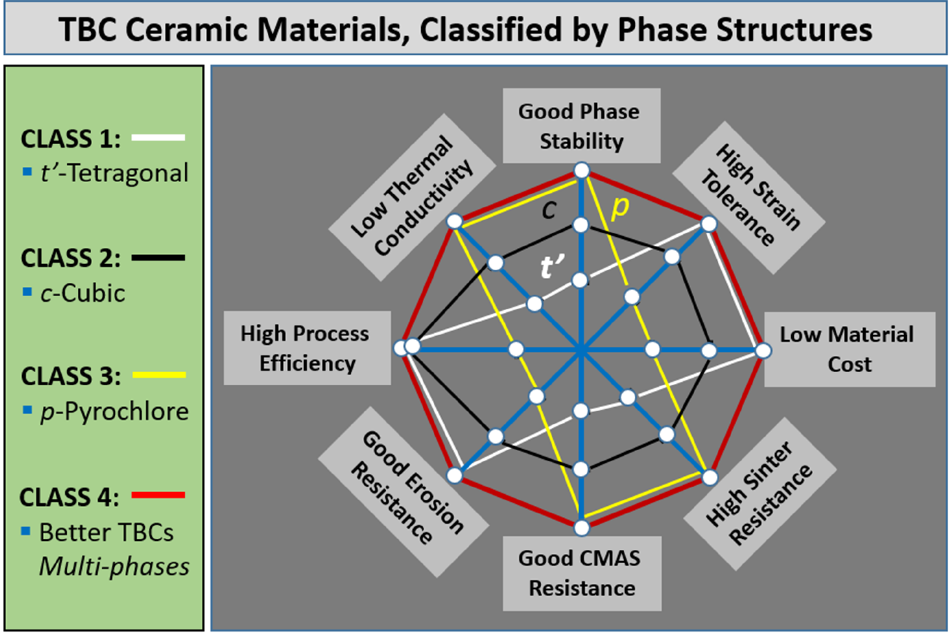
Figure 1. The aims regarding the development of new ceramic materials to meet desirable properties, performance, the coating process, and the economy targets for novel TBCs that can be used in advanced gas turbine engines.